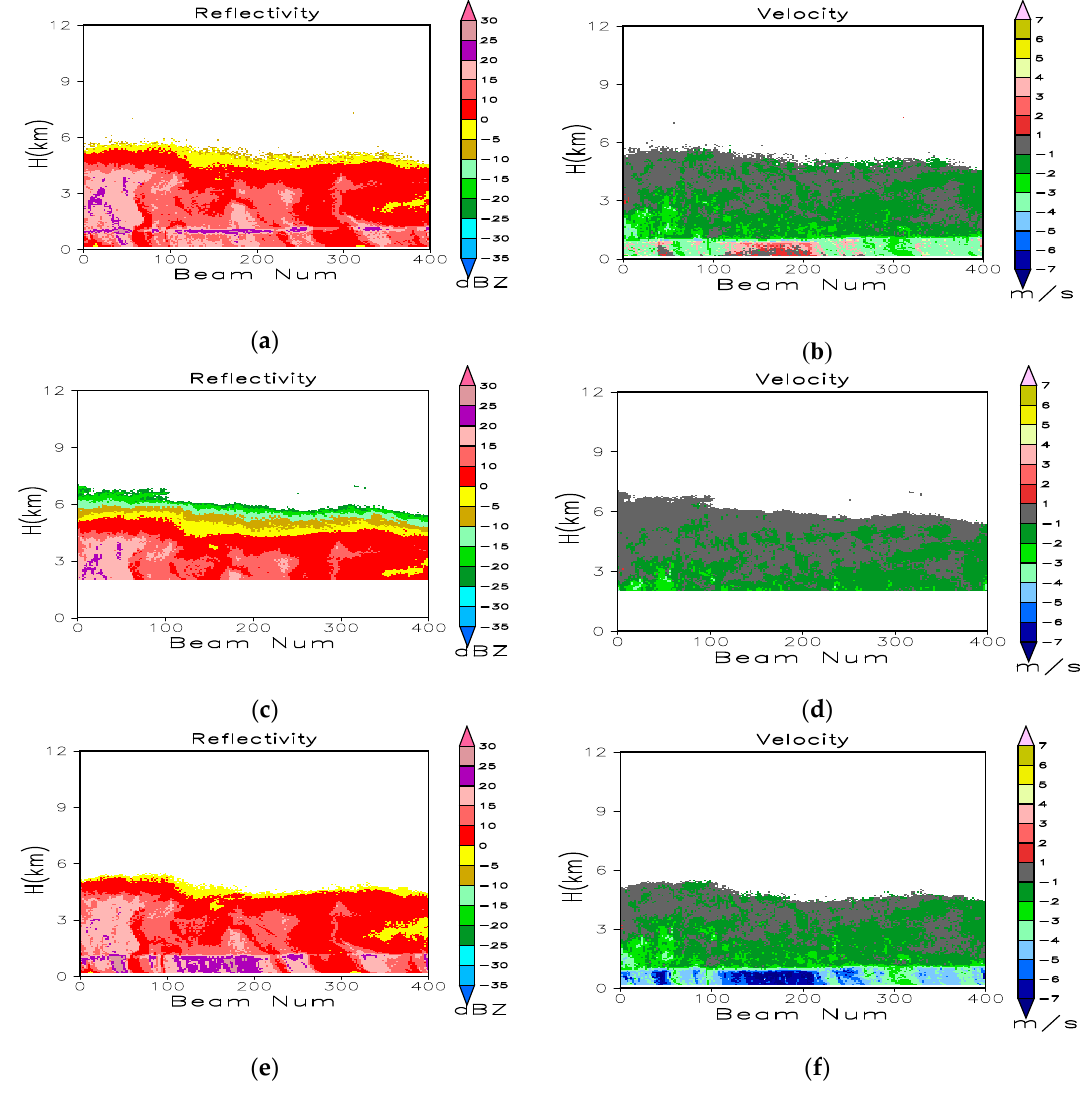
Figure 3. Time–height cross sections of 500 profiles for raw ( a ) reflectivity and ( b ) velocity observed by the M1 mode; ( c ) reflectivity and ( d ) velocity observed by the M2 mode; ( e ) reflectivity and ( f ) velocity observed by the M3 mode from 02:53 to 04:07 Beijing local time (BT) on 11 July 2014.